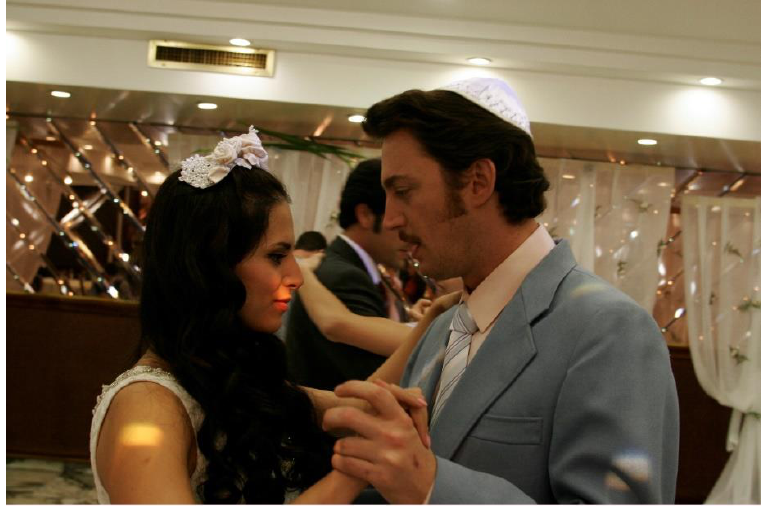
Figure 3. Dina Zvi-Riklis, Three Mothers ( Shalosh Imaot , 2006), Rose’s Wedding. Credit: Yoni Hamenachem. Used with the director’s permission.